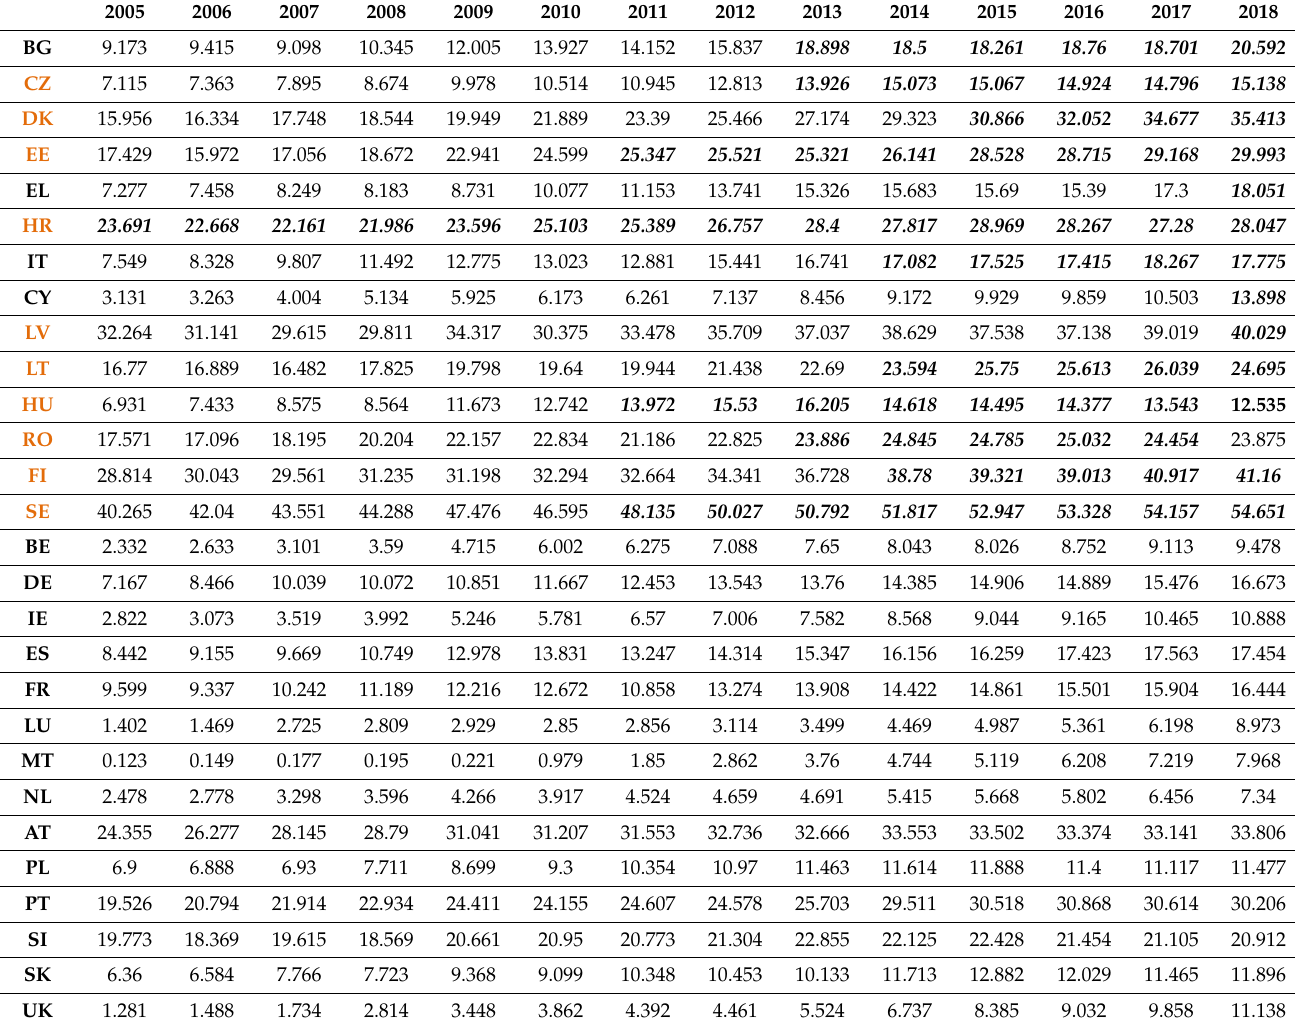
Table 1. Share of renewable energy in gross final energy